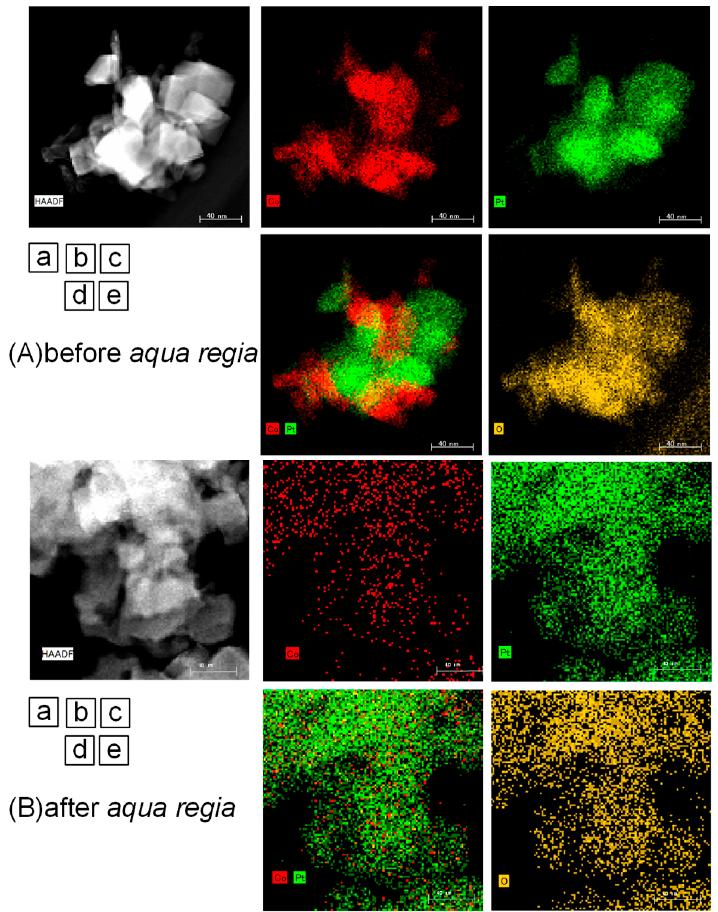
Figure 3. TEM images EDS mapping of Co-Pt bronze ( A ) before and ( B ) after aqua regia treatment.